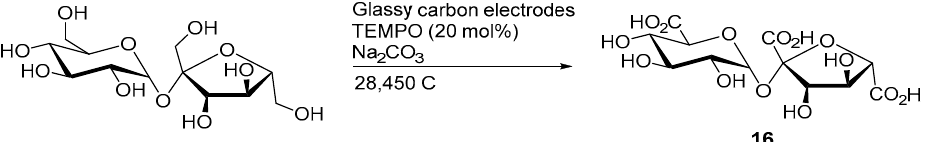
Table 2. Product distribution after electrolysis of trehalose in alkaline media at gold and gold/nickel (70/30)